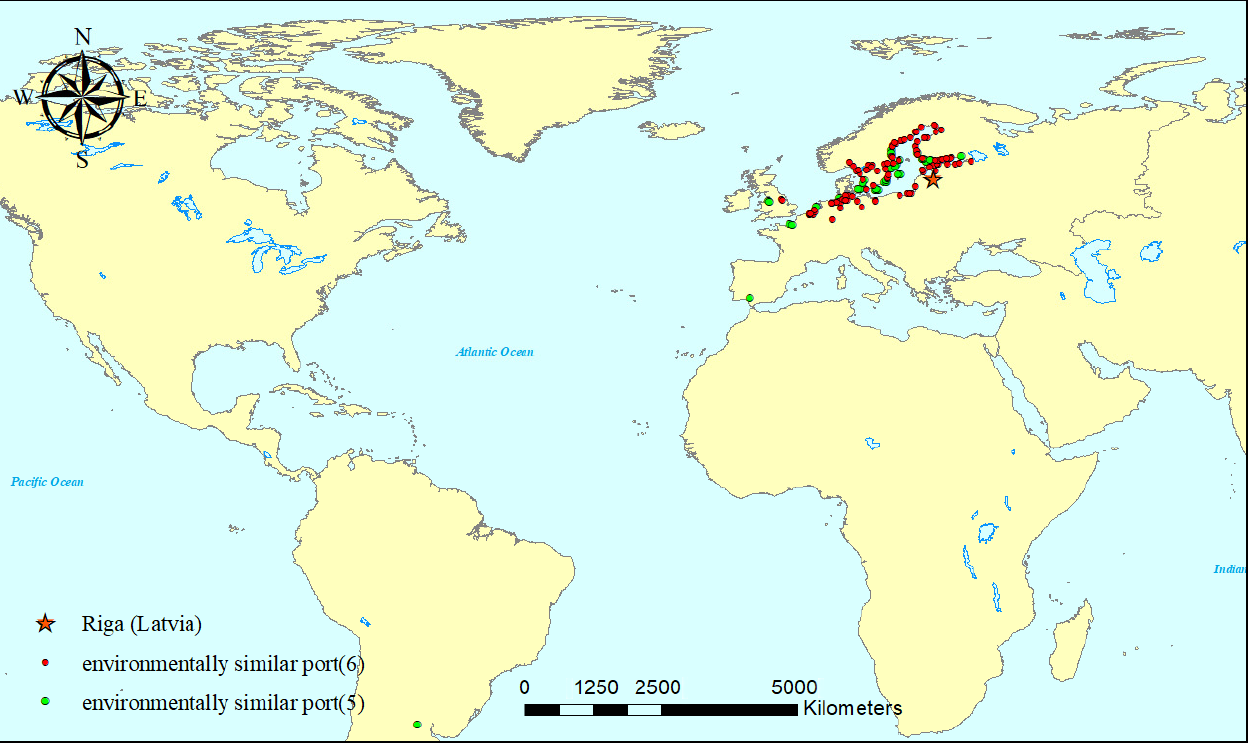
Figure 4. Location of the donor ports with similar environments to the port of Riga. The red and green solid circles represent ports with a risk score of 6 and 5, respectively, based on the criteria set in Table 1.